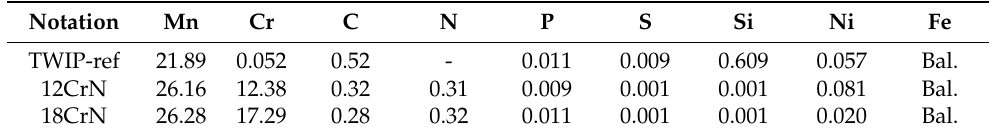
Table 1. The contents of main elements of TWIP steels